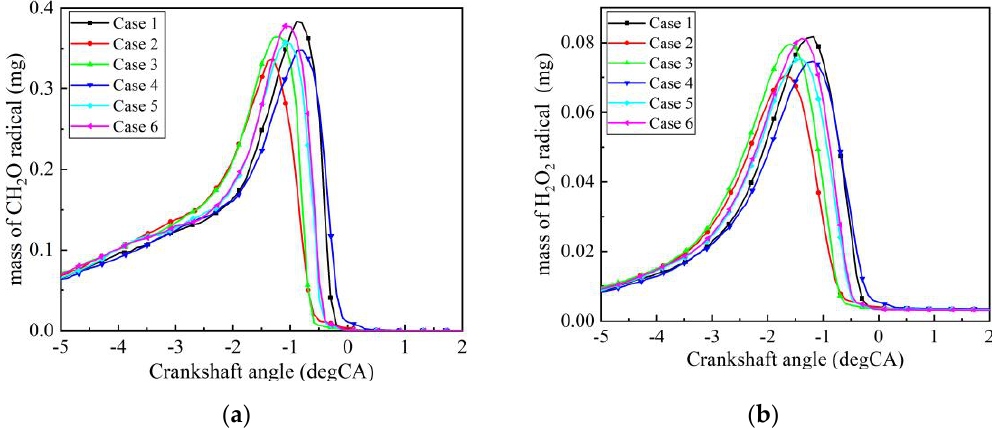
Figure 17. Instantaneous heat release rate in the cylinder in different water injection cases (CR = 10.3, ignition time = − 14 degCA).